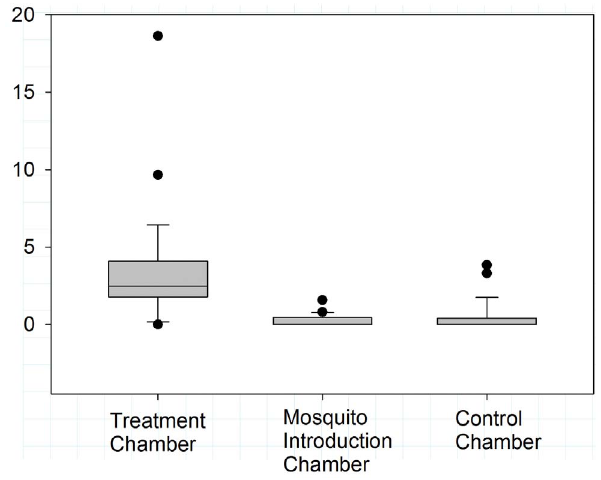
Figure 4. Box-and-whisker plot of DDT air concentration in samples collected from the treatment (Fig. 1 B), mosquito introduction (Fig. 1 C), and control (Fig. 1 D) chambers of the laboratory system (black circles denote samples above or below the 90% and 10% percentiles, respectively). Nylon fabric treated with 0.09 g/m 2 4, 4 9 DDT was prepared each day and placed on 50% of the wall surface area of the treatment chamber. The median airborne DDT concentration was significantly different between days (Kruskal-Wallis one-way ANOVA; H=35.461; P , 0.001). The DDT air concentration measured for the treatment chamber was significantly higher than the levels measured in the mosquito introduction and control chambers (Tukey post hoc ; p , 0.05 for both comparisons).